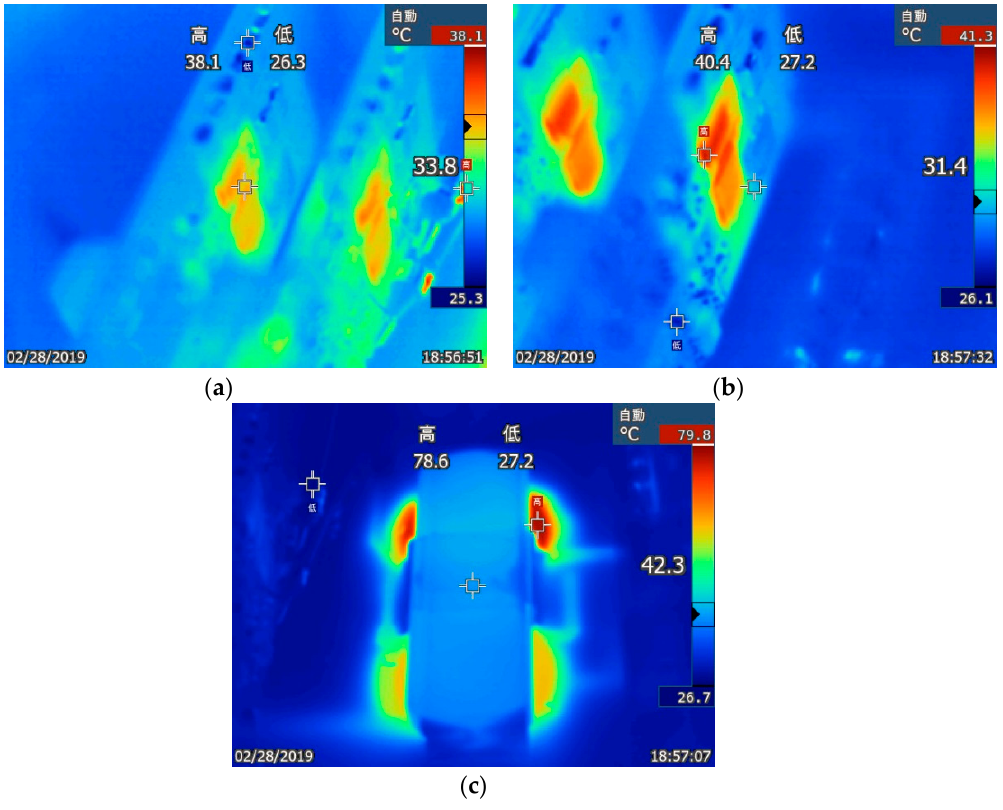
Figure 19. Temperature of the LLC converter at full load; ( a ) primary-side GaN devices, ( b ) secondary-side GaN devices, and ( c ) core and winding of transformer.